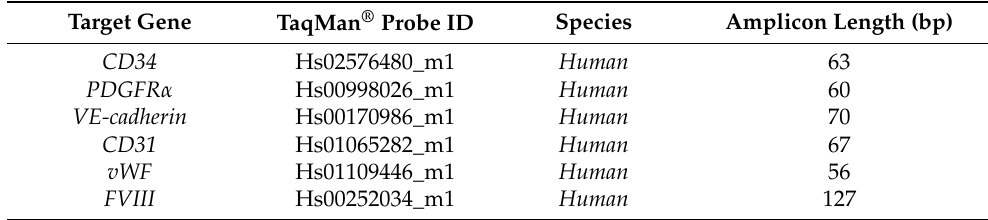
Table 1. Oligonucleotides for qPCR analysis. TaqMan ® Gene Expression Assays for relative gene expression analysis. Abbreviations: PDGFR α , Platelet Derived Growth Factor Receptor Alpha ; VE- cadherin , vascular endothelial cadherin ; vWF , von Willebrand factor, FVIII, factor VIII . Target Gene TaqMan ® Probe ID Species Amplicon Length (bp)